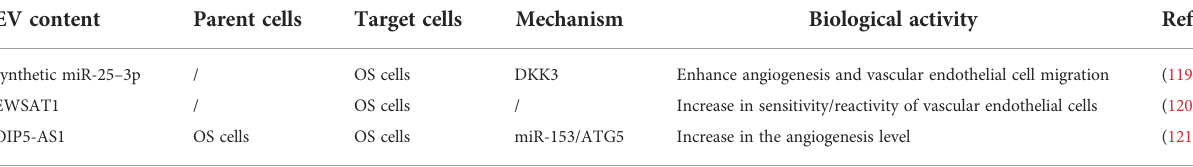
TABLE 3 The biological function of exosome in the angiogenesis of OS. EV